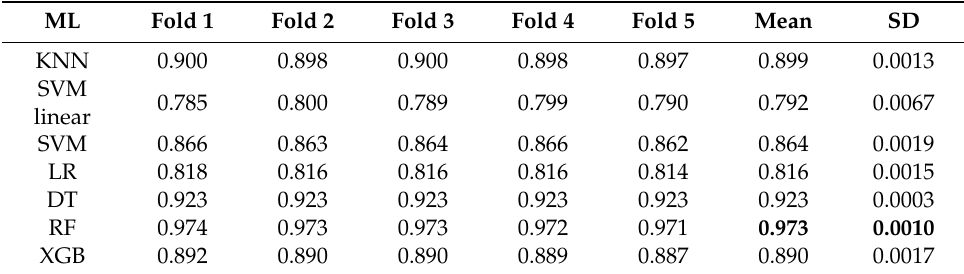
Table 1. Area Under the Receiver Operating Characteristics (AUROC) values for seven Machine Learning (ML) methods (five-fold cross-validation